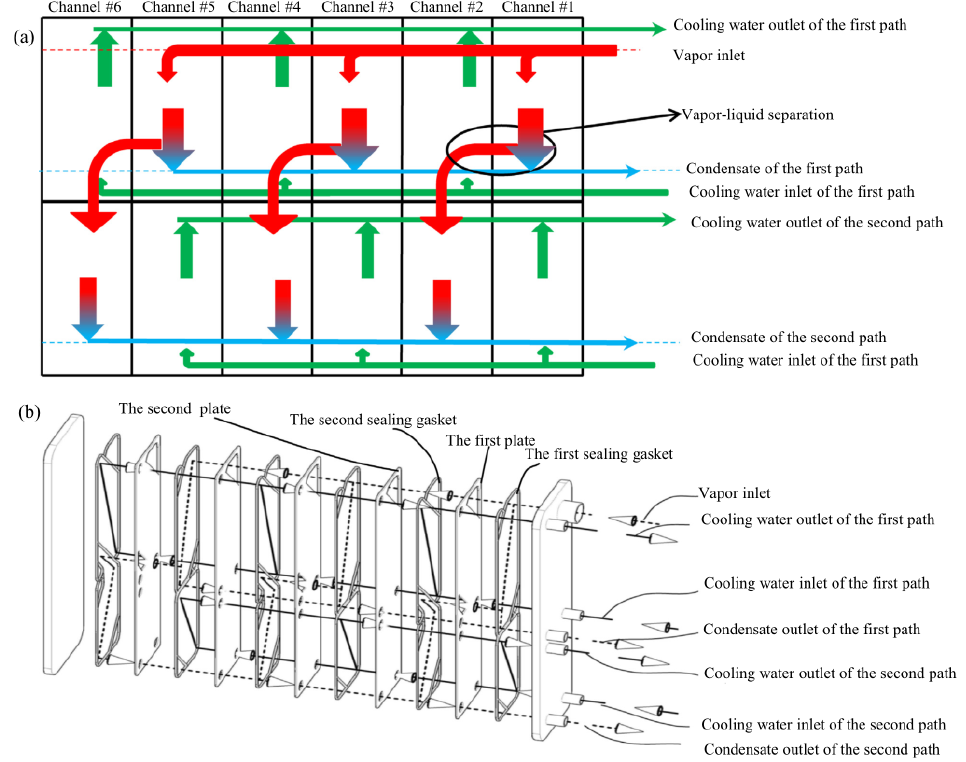
Figure 10. A plate type liquid-separation condenser: ( a ) schematic; and ( b ) conceptual designed configuration [68]. Reproduced with permission from Luo et al., Energy Conversion and Manage- ment; published by Elsevier, 2017.